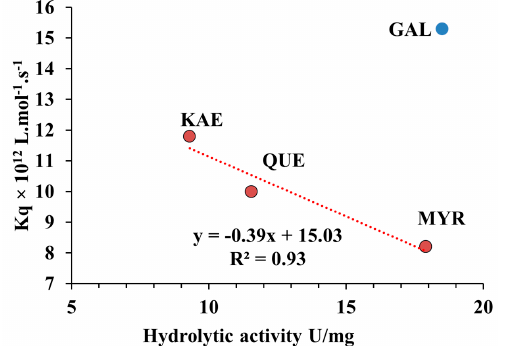
Figure 10. Relationship between the hydrolytic activity of 2.5 µM CpLIP2 lipase measured at 30 °C mixed with each flavonol (GAL, KAE, QUE, MYR) at 14 µM after 30 min of pre-incubation and their mixed with each flavonol (GAL, KAE, QUE, MYR) at 14 µ M after 30 min of pre-incubation and their bimolecular quenching constant K q determined at 35 °C . GAL, galangin , KAE, kaempferol; QUE, quercetin; MYR, myricetin. bimolecular quenching constant K q determined at 35 ◦ C. GAL, galangin, KAE, kaempferol; QUE, quercetin; MYR,